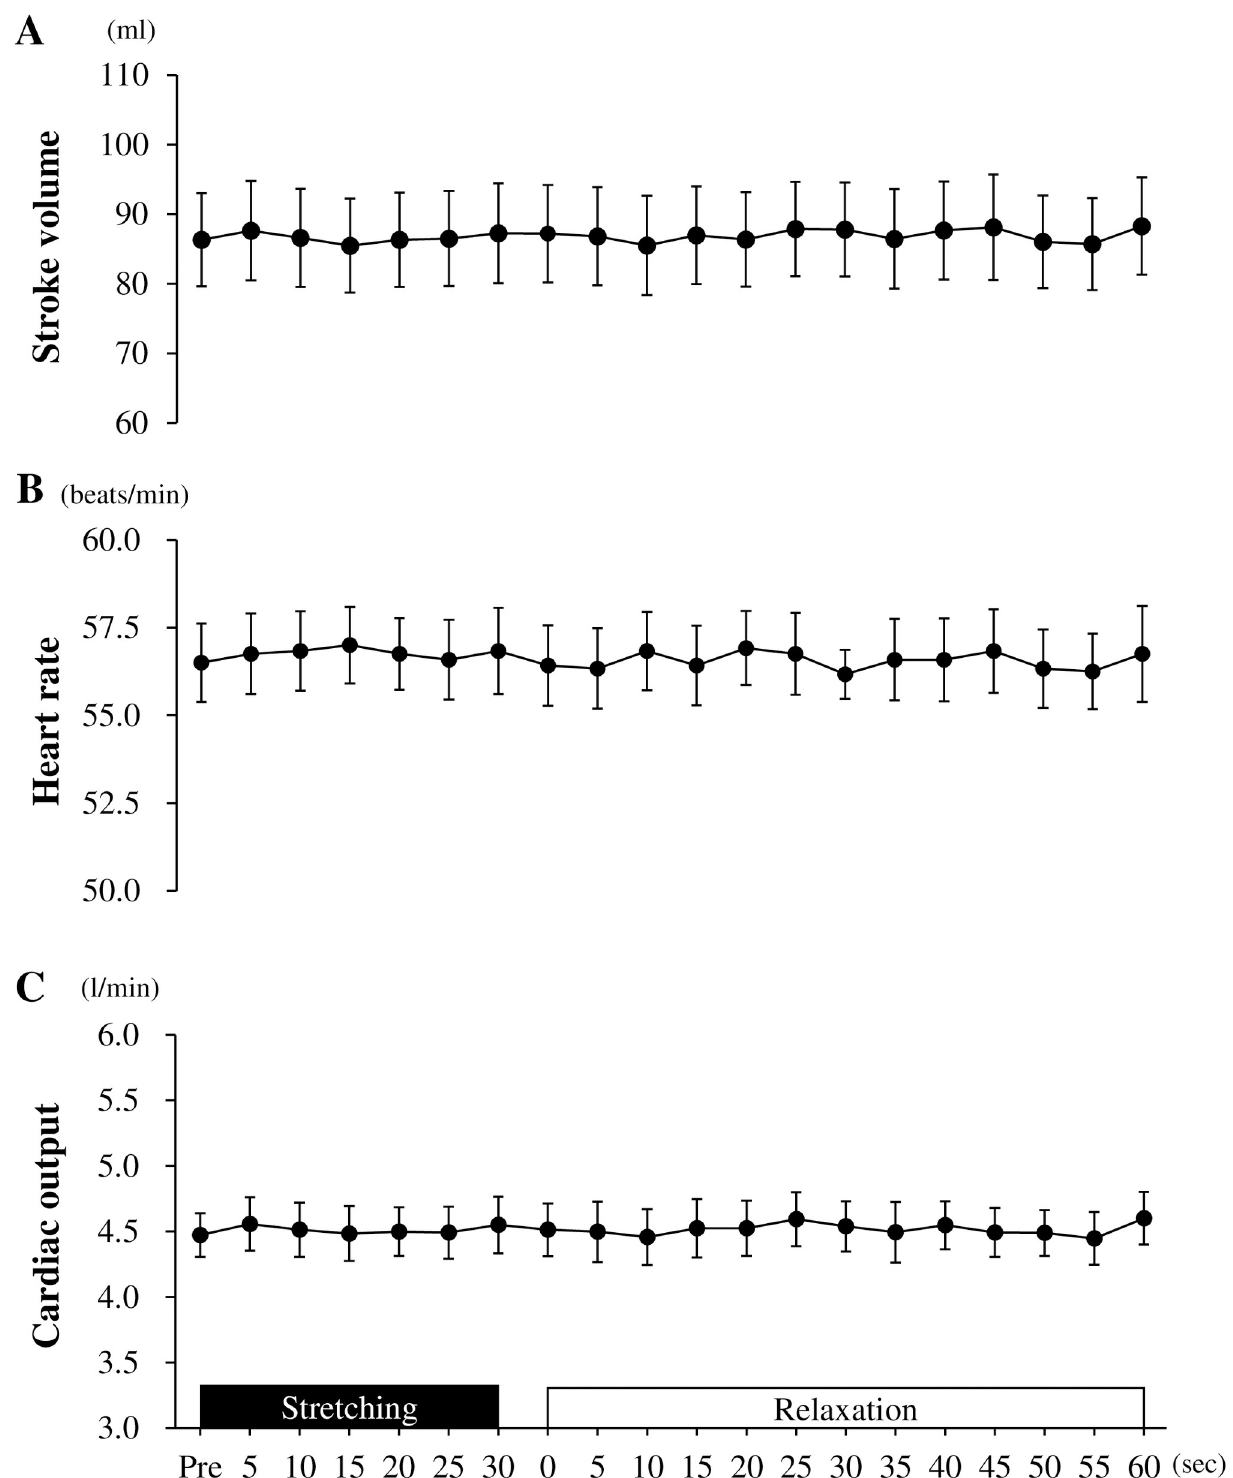
Fig 3. Stroke volume (A), heart rate (B), and cardiac output (C) before, during, and after passive one-legged calf stretching. Pre, before stretching; Data are presented as mean ± SE.